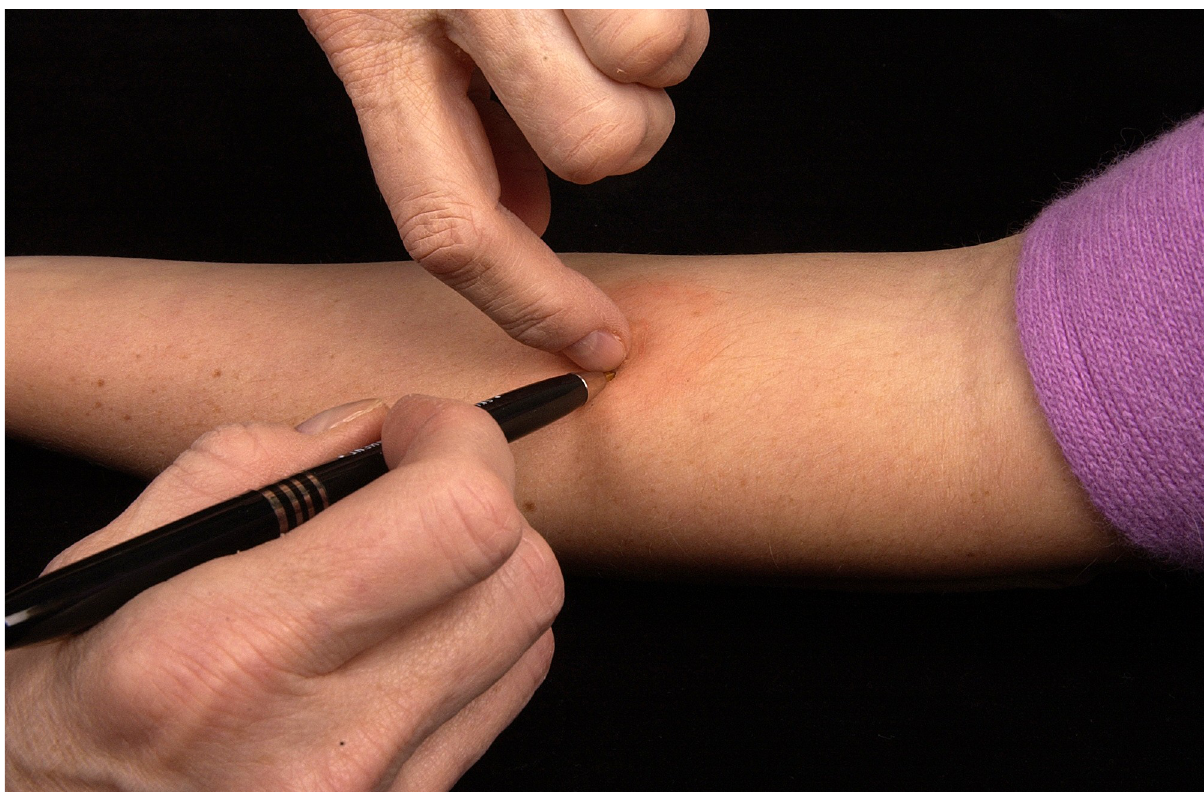
Fig 1. Ballpoint pen method for reading transverse diameter of induration. A ballpoint pen is placed a few centimeters from the edge of the induration and lightly moved across the skin toward the induration, drawing a line on the skin. When the tip of the pen reaches the boundary of the induration, added pressure is felt by the hand holding the pen, at which point the pen is lifted from the skin. Thus, the end of the line marks a boundary of the induration. Image from CDC Public Health Image Library [58].